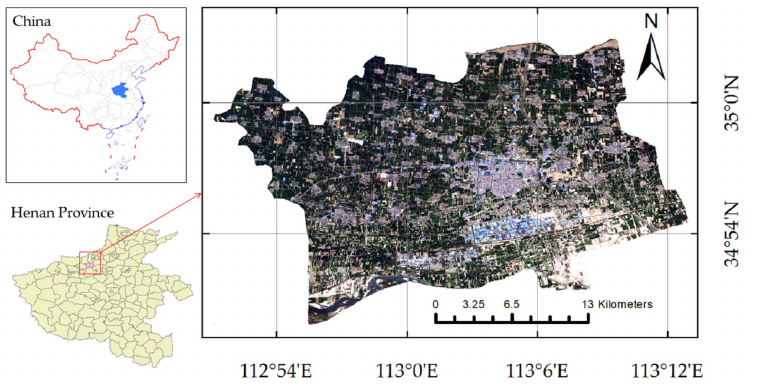
Figure 1. Geographical location of study area.